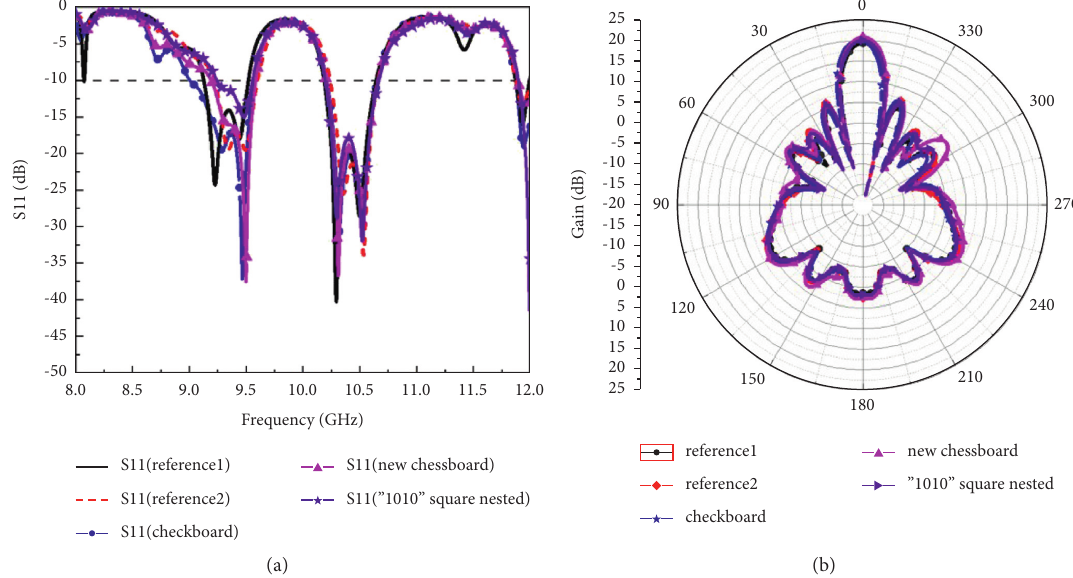
Figure 7: Simulated radiation results of different layouts; (a) amplitude of reflection of various structures; (b) comparison between realized gains of different